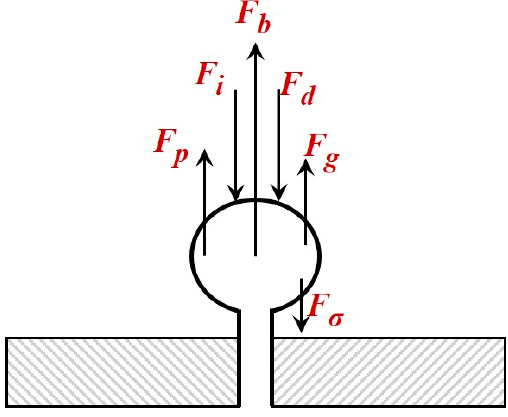
Figure 1. Forces acting on an under-formation bubble (Table 1). Table 1. Forces acting during bubble